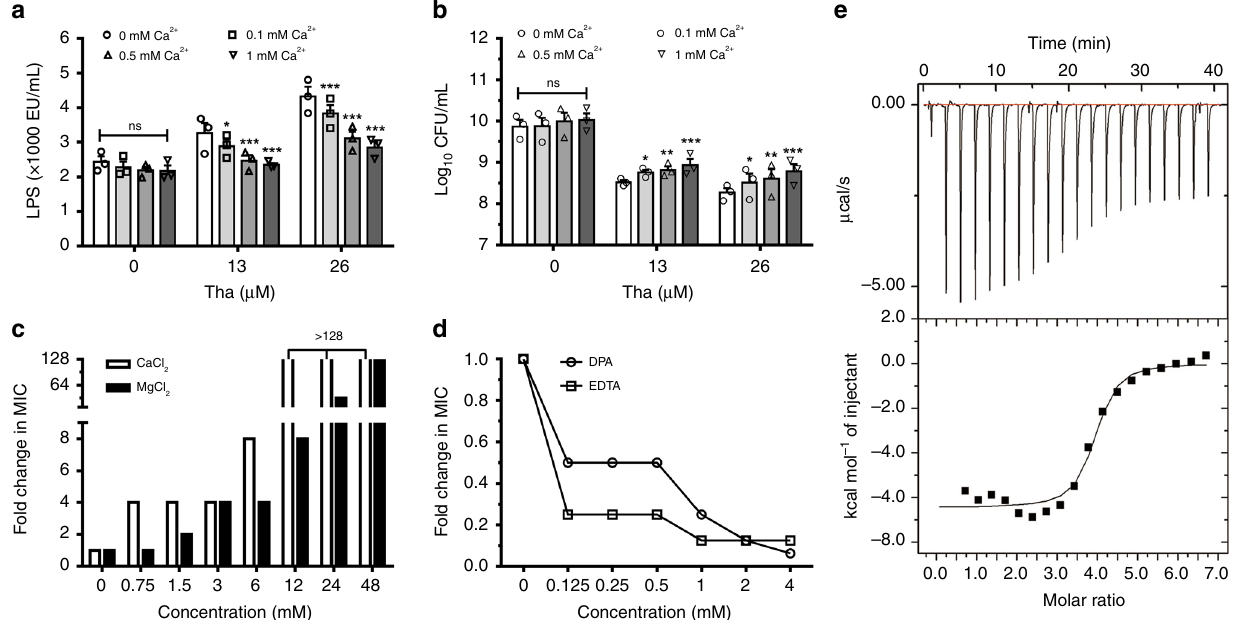
Fig. 3 Thanatin replaces divalent cations from LPS. a , b Effects of Ca 2 + on thanatin-induced LPS release from NDM-1-producing E. coli XJ141026 ( a ) and CFUs ( b ) after treatment with 13 or 26 μ M thanatin. c , d Effect of the divalent cations Ca 2 + or Mg 2 + ( c ) or the metal-chelating agents DPA or EDTA ( d ) on the MIC of thanatin against NDM-1-producing E. coli XJ141026. e ITC thermograms for the binding of LPS to thanatin. The downward peaks indicate an exothermic process. All data are shown as the mean ± s.e.m. from three independent experiments. P- values were determined by two-way ANOVA ( a , b